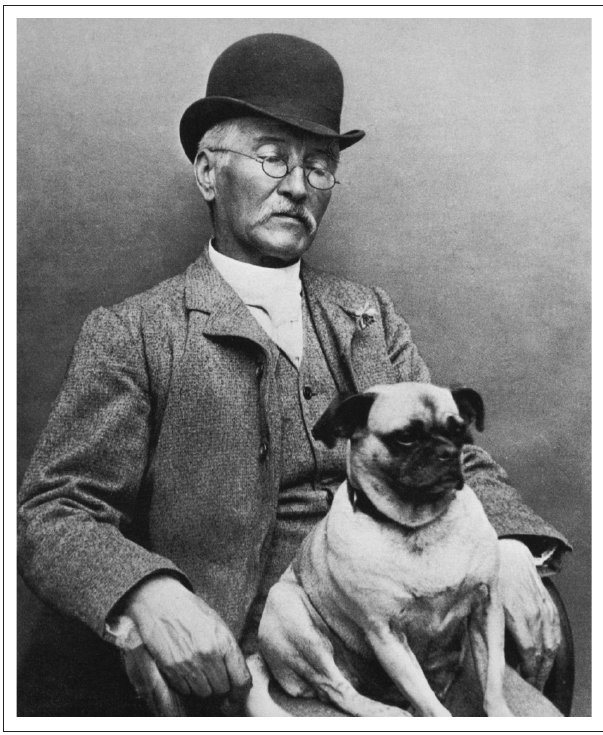
FIGURE 1: Prof. Peter MacOwan (1830–1909).